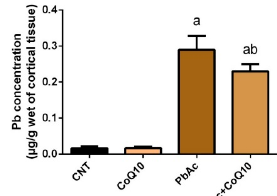
Figure 1. The effects of lead acetate and/or coenzyme Q10 on cortical lead concentration. Results represent the mean ± SD ( n = 7); significant changes at P < 0.05 were determined using Duncan’s post-hoc test. a significant change compared with the control group; b significant change compared with the PbAc injected group.